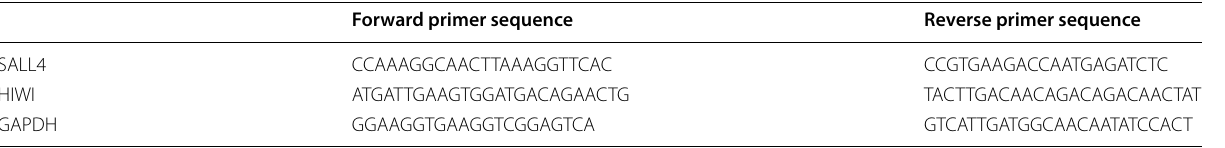
Table 1 Primer sequences used for quantitative real-time RT-PCR Forward primer